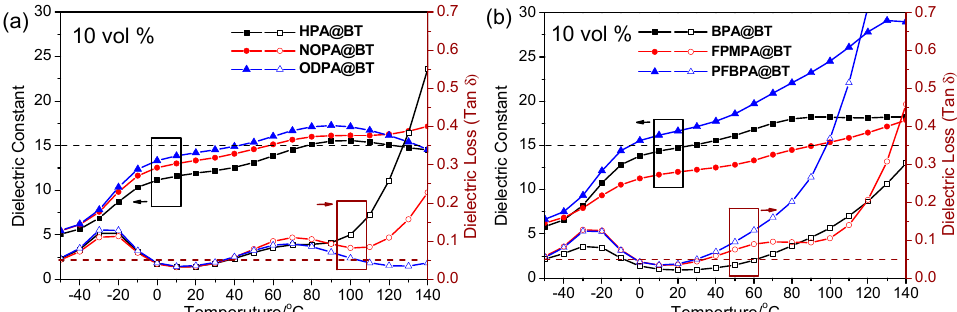
Figure 4. Temperature-dependent dielectric spectra of representative 10 vol% loading nanocomposite films . ( a , b